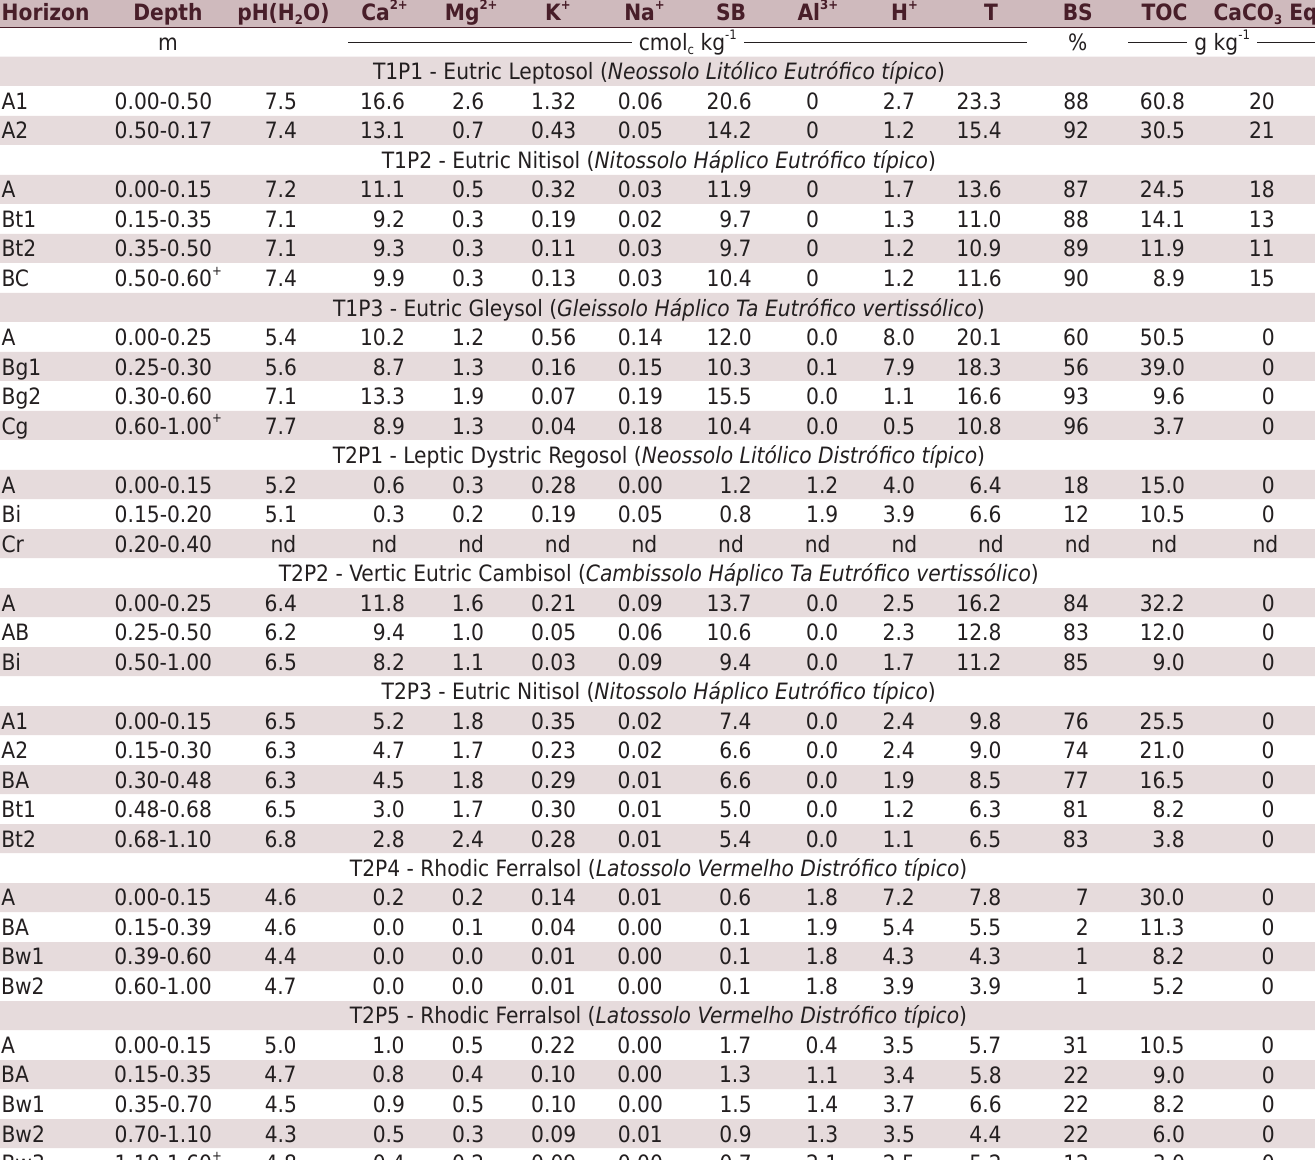
Table 1. Chemical properties of soil profiles from two lithotoposequences located in the Montes Claros (MG, Brazil) microregion Horizon